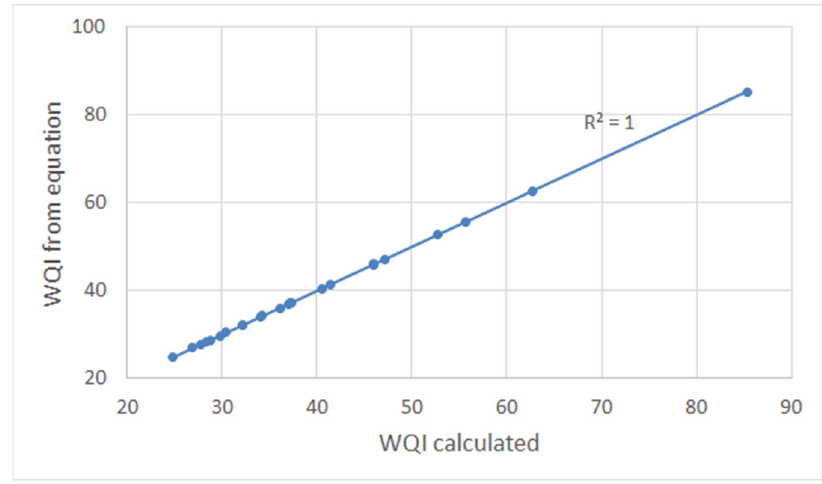
Figure 6. WQI validation from 2011 to 2012.